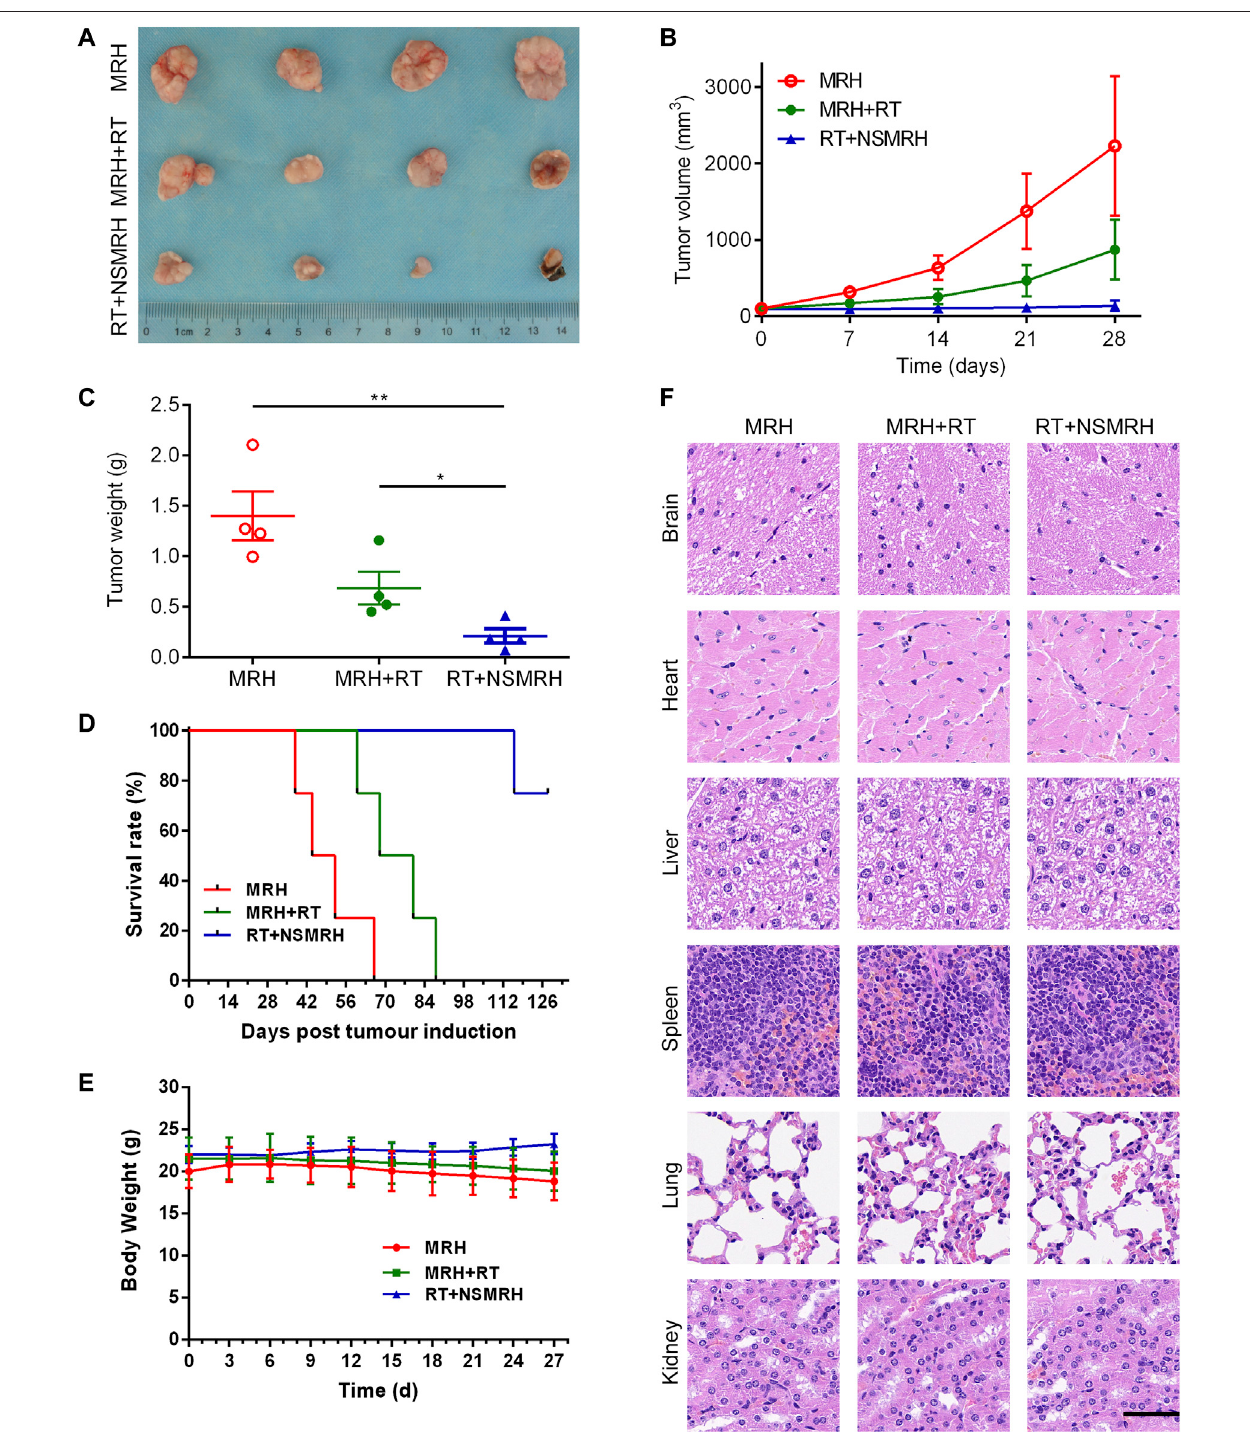
FIGURE 4 | NSMRH inhibits tumor recurrence in vivo . (A) in vivo tumor tissue imaging about recurrence of subcutaneously transplanted tumor in mice after resection. (B) Tumor growth curves of different groups up to 28 days. (C) Tumor weight curves of different groups. (D) The survival rates of nude mice after treatment were illustrated by Kaplan – Meier curves. (E) Bodyweight changes of the mice during treatments. (F) Histological sections of the main organs (brain, heart, liver, spleen, lungs, and kidneys) were stained by H&E, scale bars: 100 μ m.